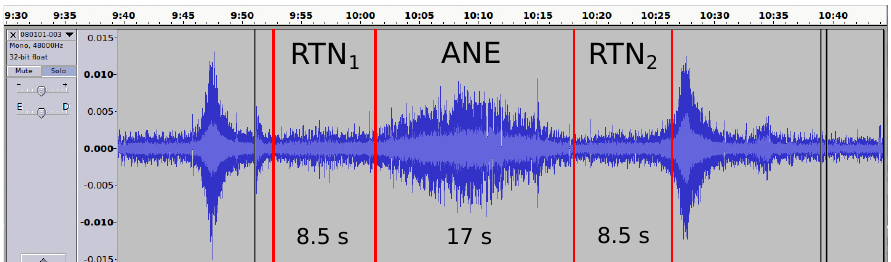
Figure 2. An example of the SNR and duration measurement of a raw acoustic signal corresponding to a 17 s long train ANE. The ANE presents a SNR of 6.6 dB, resulting in an impact of 1.1 dB when the L A 5 min is calculated, and uses a 5 min time interval evaluation. The left and right RTN regions used to calculate the SNR are marked as RTN 1 and RTN 2 ,